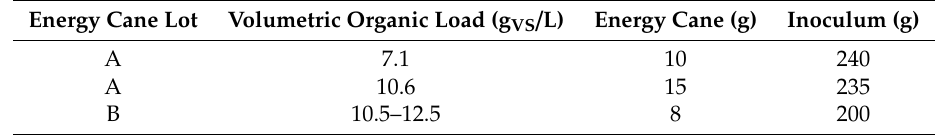
Table 1. Batch tests: volumetric organic load, initial substrate weight, and amount of the inoculum. Energy Cane